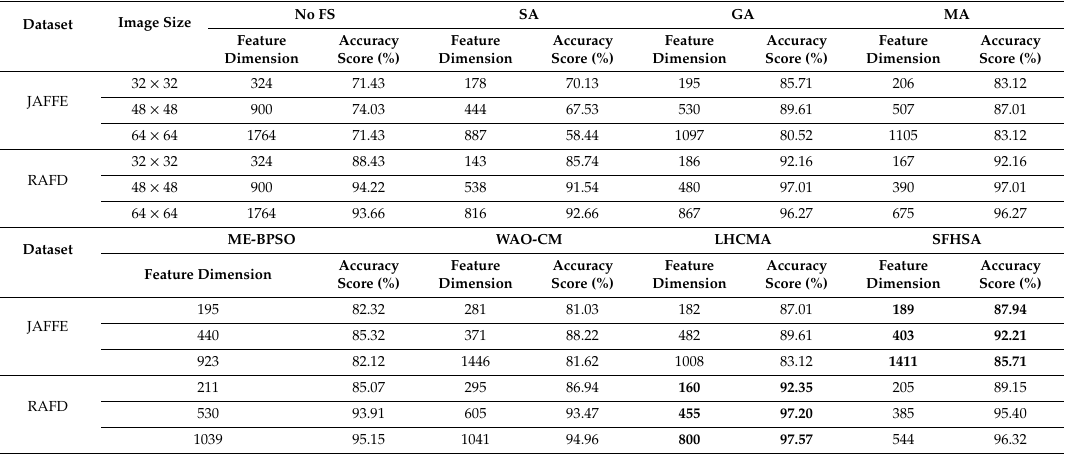
Table 6. Performance of SFHSA with respect to No FS, SA, GA, MA, ME-BPSO, WAO-CM and LHCMA for HOG features.